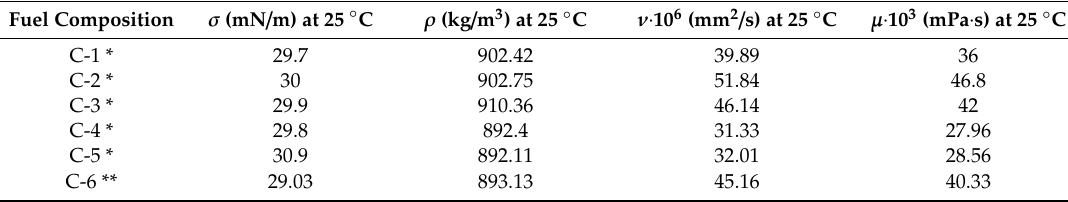
Figure 2. Water-in-diesel and water-in-biodiesel fuel compositions under study. Table 3. Water-in-diesel and water-in-biodiesel micro-emulsion properties: surface tension ( σ ), density ( ρ ), kinematic viscosity ( ν ), and dynamic viscosity ( µ ).